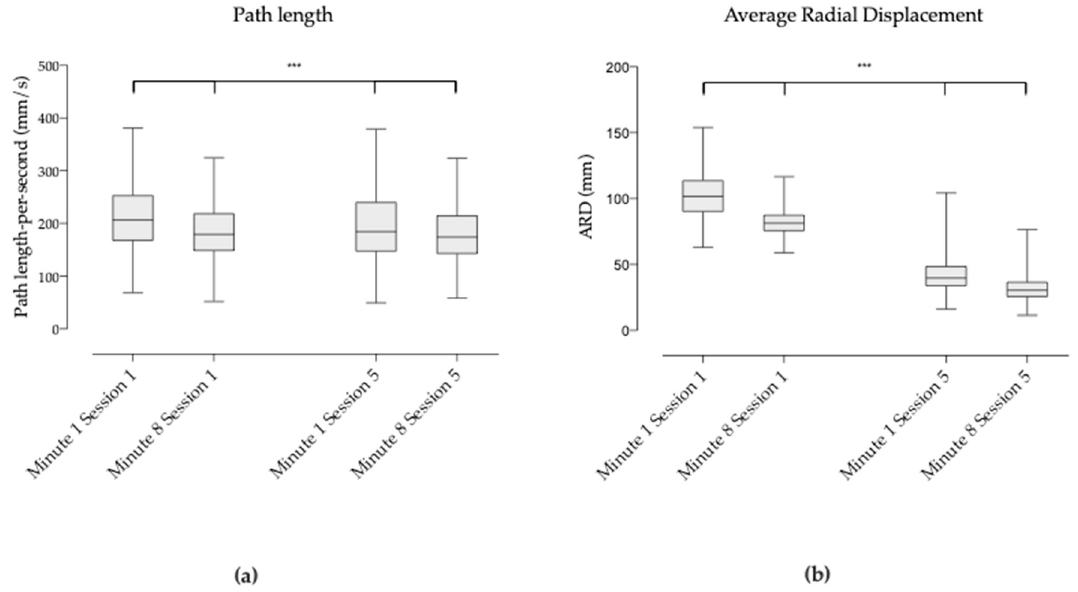
Figure 3. ( a ) Box and whiskers diagram of the COP path length in mm / s of the first two min. versus the last two min. of sessions 1 and 5; ( b ) Box and whiskers diagram of the COP Average radial displacement (ARD) in mm of the first two min. versus the last two min. of sessions 1 and 5.